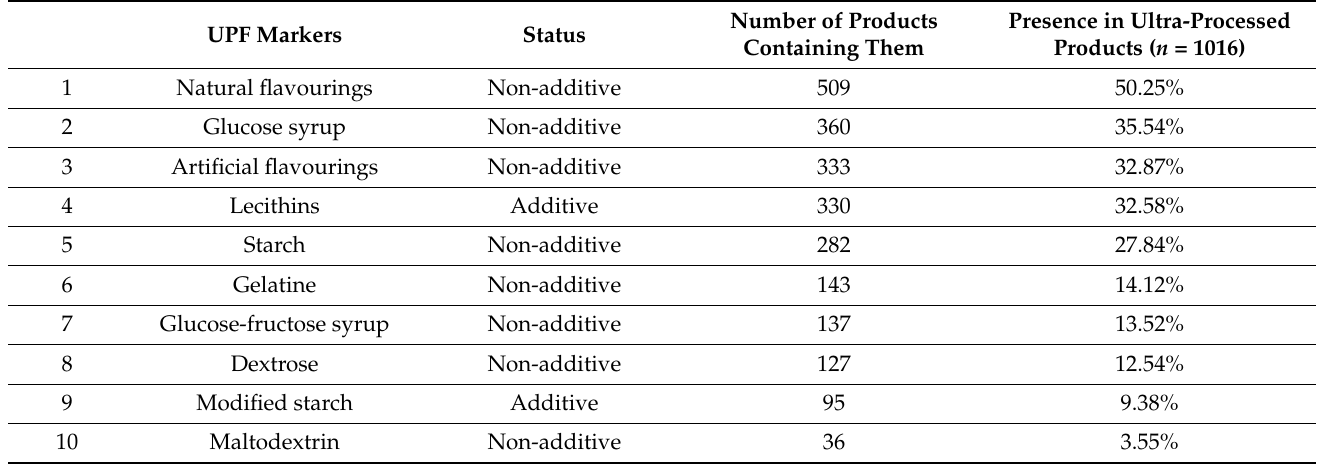
Table 7. Main UPF markers found in ultra-processed